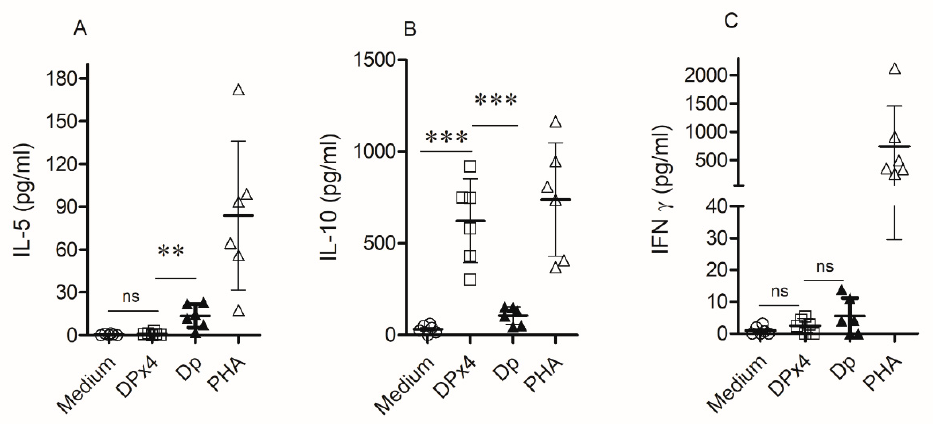
Figure 6. Cytokine response induced by DPx4 in cultures of peripheral blood mononuclear cells (PBMC) from six house dust mite (HDM) allergic patients. Culture supernatants were collected and levels of IL-5 ( A ), IL-10 ( B ), and IFN γ ( C ) were measured by flow cytometry. Results are expressed as the mean and their SD from the six samples. (** p < 0.05, *** p < 0.001). 2.7. DPx4 Induced IgG Antibodies that Inhibited Patient’s IgE Reactivity to D. pteronyssinus